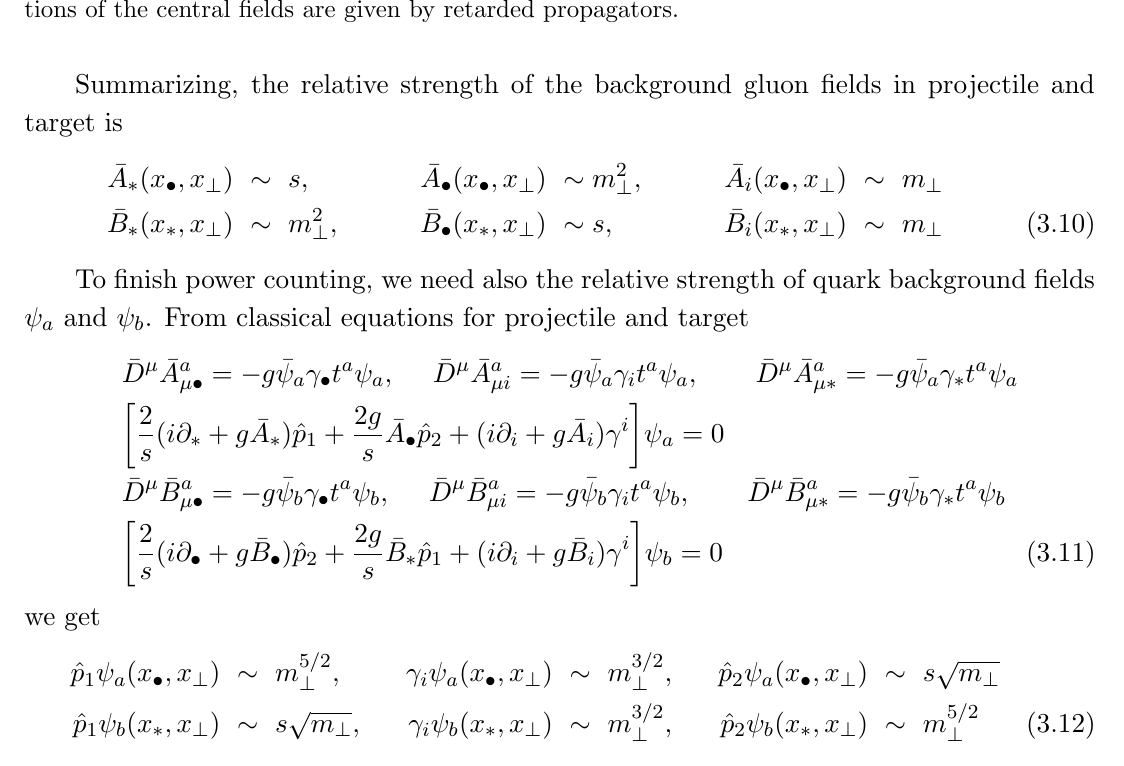
Figure 3 . Typical diagram for the classical (cid:12)eld with projectile/target sources. The Green func- tions of the central (cid:12)elds are given by retarded